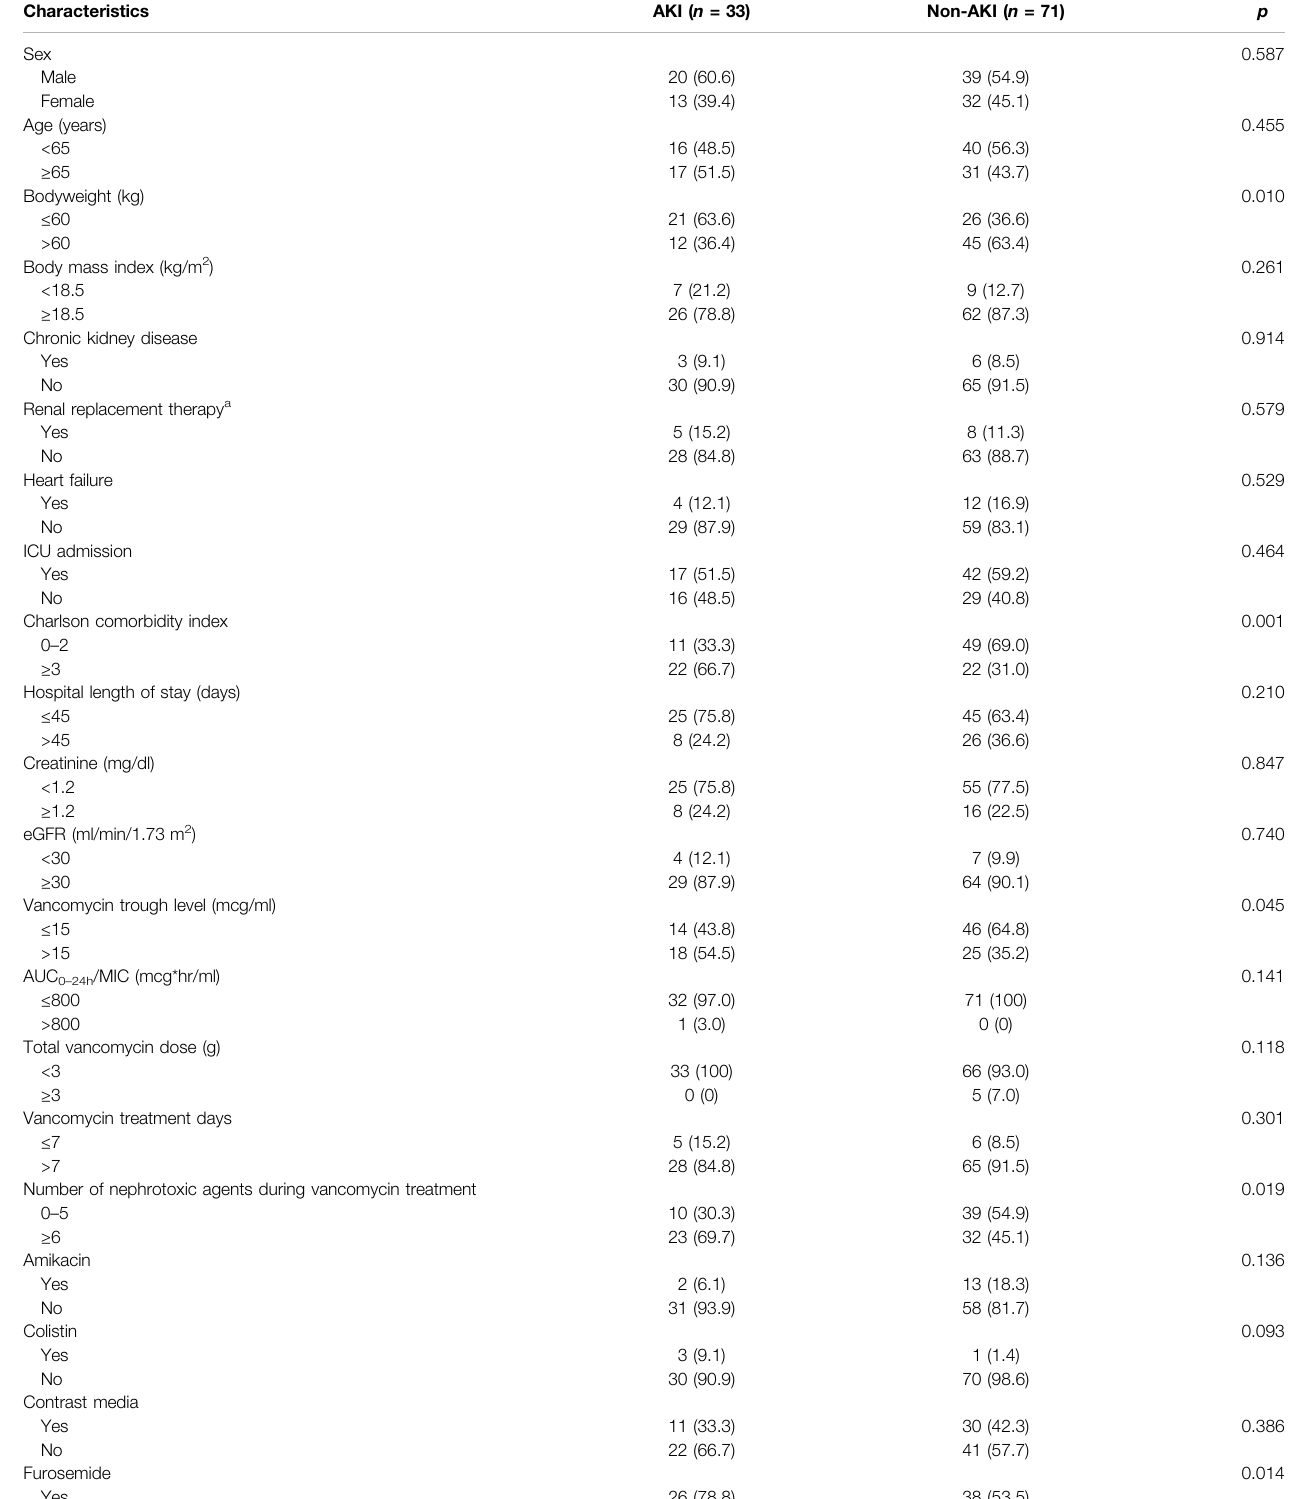
TABLE 1 | Association of patient characteristics with AKI.